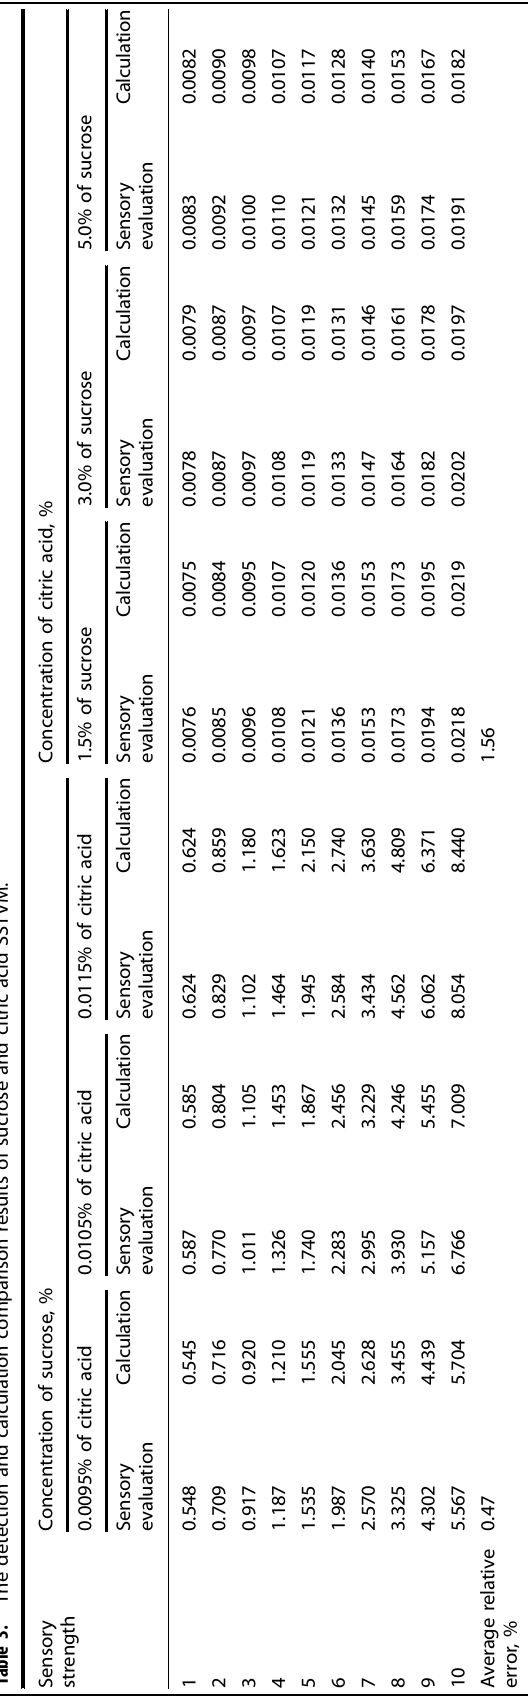
Supplementary Table 2. Before the sensory analysis, all the sucrose and citric acid test samples were kept at 20